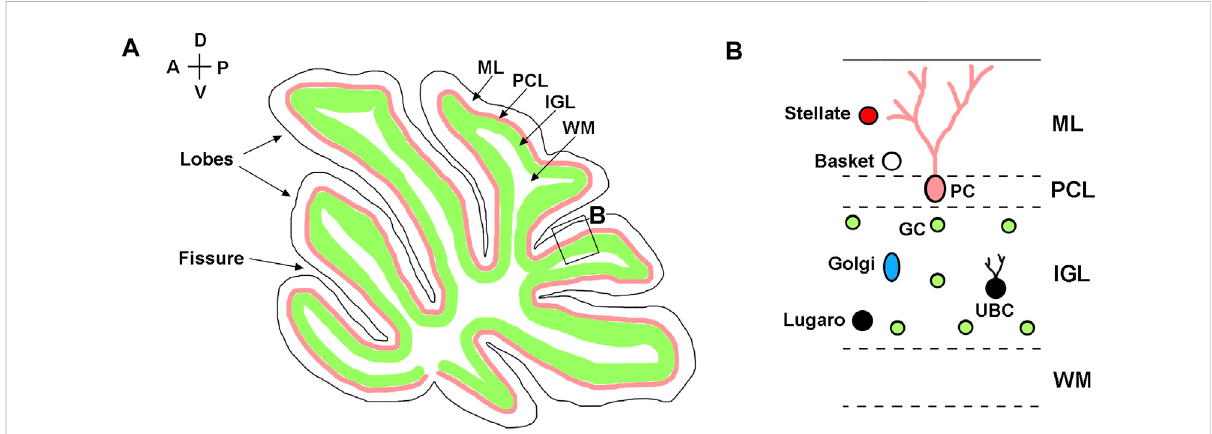
FIGURE 1 Neuroanatomyofadultcerebellum. (A) Diagramofasagittalsectionoftheadultmousecerebellum,showinglayeredstructureofthecerebellar cortex, which is subdivided by parallel fi ssures into distinct lobes. (B) Higher magni fi cation of the region boxed in panel (A) . Molecular layer — ML; Purkinje cell layer — PCL; internal granule layer — IGL; white matter — WM; Purkinje cells — PC; granule cells — GC; Basket cells — Basket; Stellate cells — Stellate;Lugarocells — Lugaro;Golgicells — Golgi;Unipolarbrushcells — UBC.Theanterior-posterior (A – P)anddorsal-ventral(D – V)axes are shown in the top left